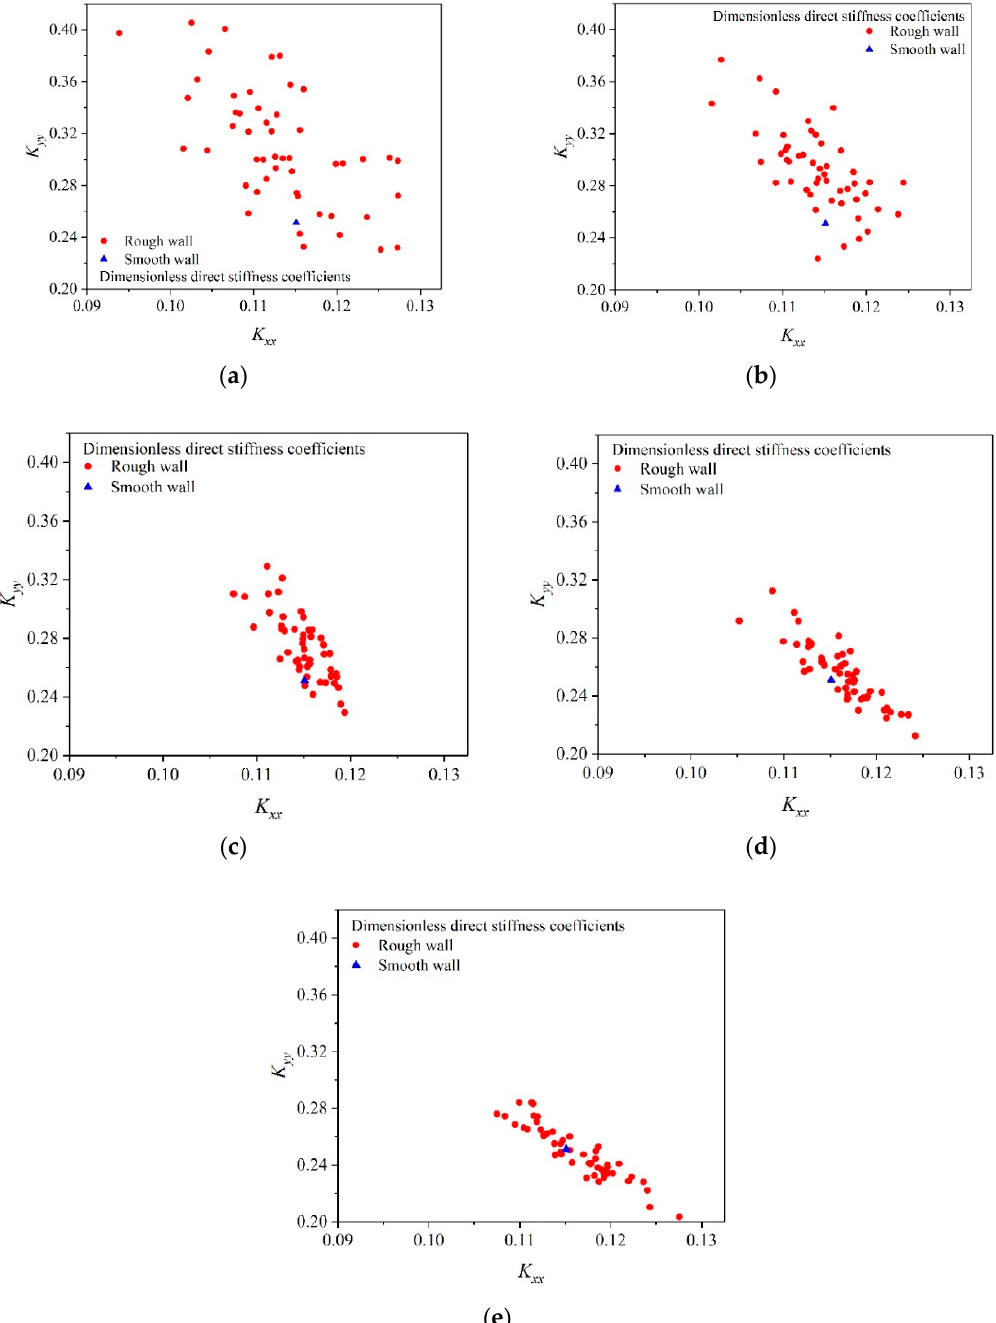
Figure 9. Direct stiffness coefficients distribution with wear in axial regions. ( a ) axial region 1. ( b ) axial region 2. ( c ) axial region 3. ( d ) axial region 4. ( e ) axial region 5.